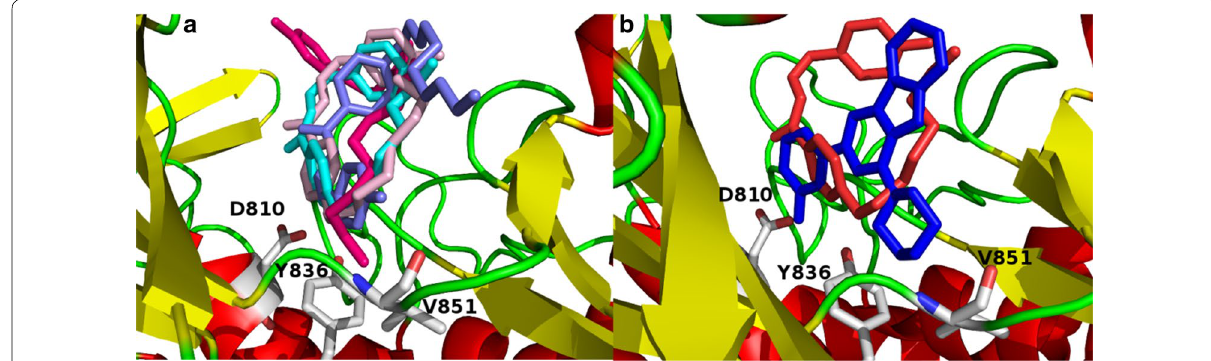
Fig. 2 The catalytic kinase domain of ( a ) 2RD0 harbors the QPLD docked poses of some of the verified molecules 2 – 9 and ( b ) superposition of the QPLD docked pose 2 and the co‑crystallized ligand represented in red and blue colors, respectively